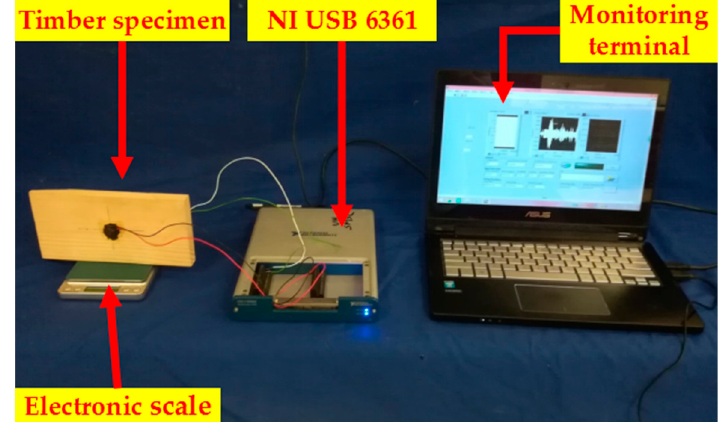
Figure 3. The experimental setup.